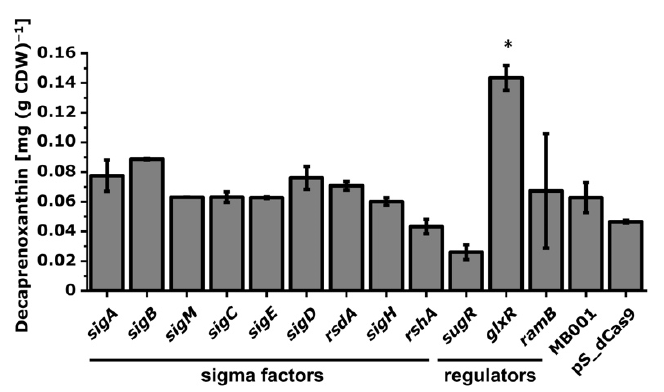
Figure 8. Influence of CRISPRi-mediated repression of RNA polymerase sigma factor and transcriptional regulator genes on decaprenoxanthin biosynthesis. Mean values of biological duplicates are given. Statistical analysis was calculated with ANOVA against all measured decaprenoxanthin production of C. glutamicum MB001 from all Biolector ® flowerplates and is marked by a star (*). As a reference, the decaprenoxanthin production of the empty vector strain C. glutamicum MB001 (pS_dCas9) in biological duplicates of the corresponding experiment is shown. For abbreviations, see Figure 3.